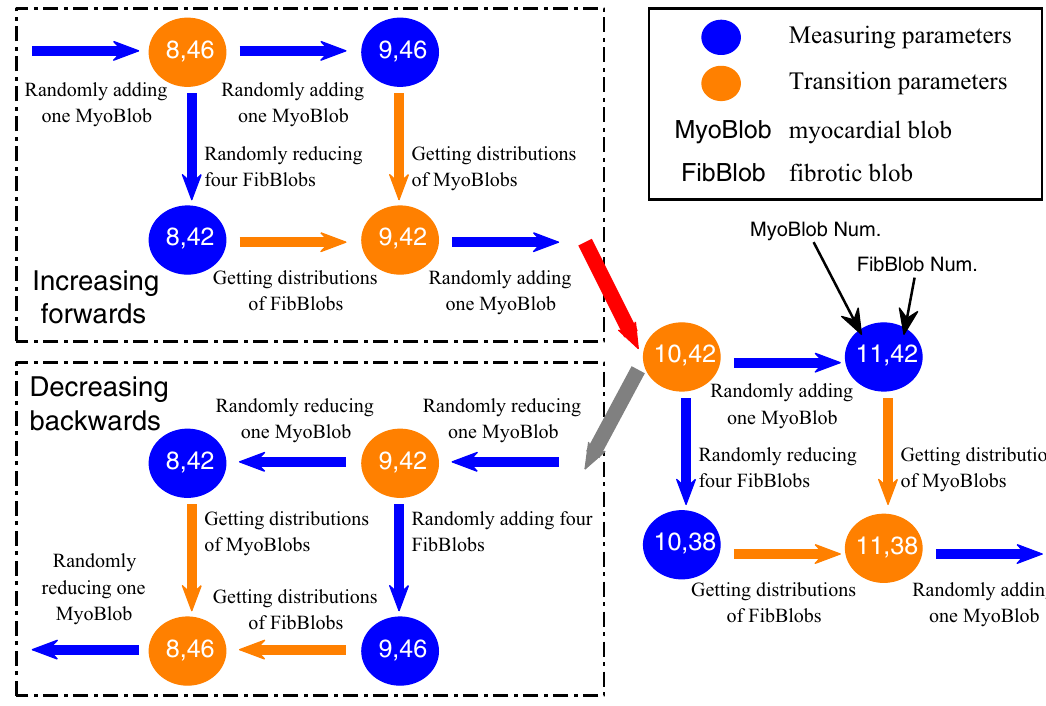
Fig 2. Flow chart of the proposed interrelated method on an isolation layer and its adjacent fibrotic layer. Blue arrows denote the changes of fibrotic blobs or myocardial blobs, and orange arrows denote the same distributions of fibrotic blobs or myocardial blobs. The red arrow denotes the use of the forward box, and the gray arrow denotes the use of the backward box. The measuring parameters are used to produce a series of interrelated simulations.